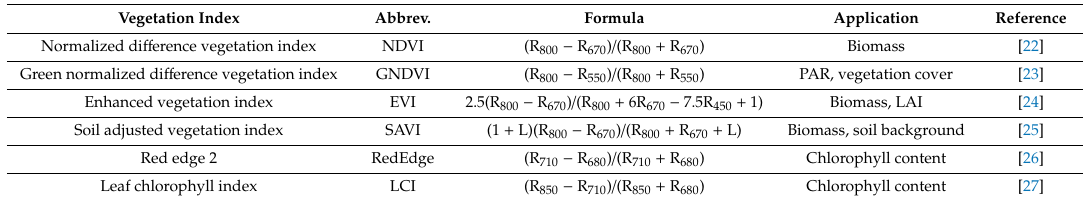
Table 1. Vegetation indices applied in this